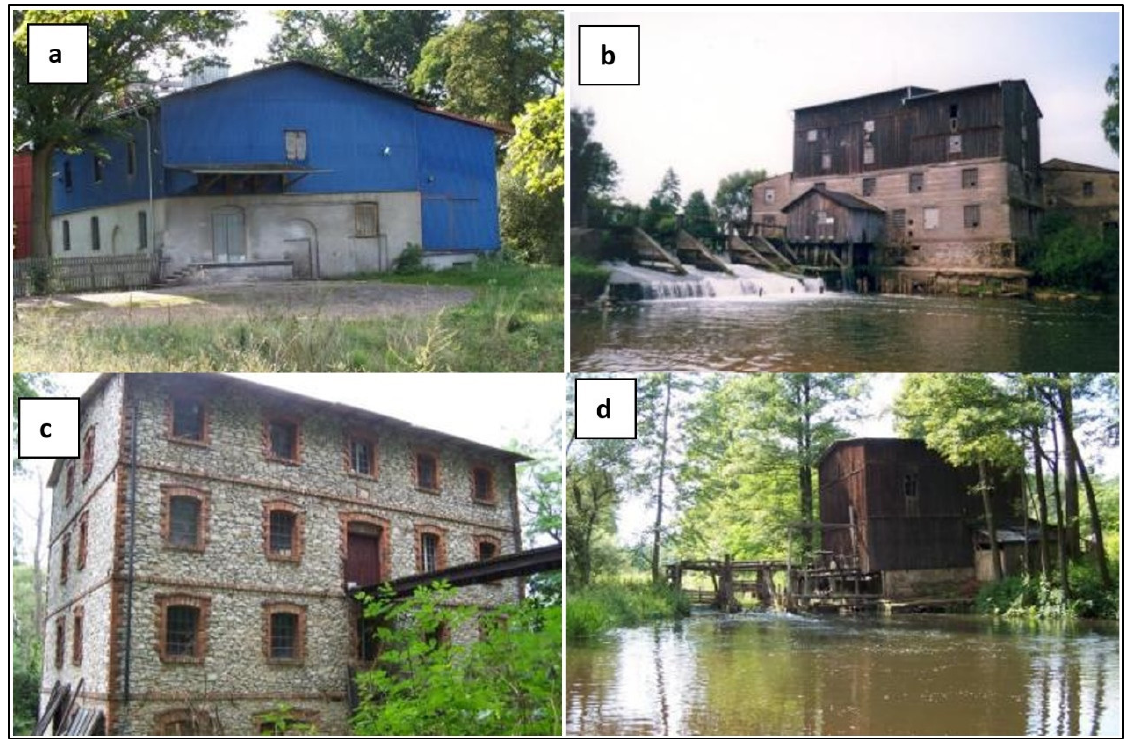
Figure 18. Contemporary Poland water mills: ( a ) historic mill in Kuźnica Stara on the River Pankówka, constructed in the early 20th century; ( b ) Marcelin mill in Krzepice, constructed in 1876; ( c ) mill in Troniny on the River Liswarta, constructed in 1901; and ( d ) Krym mill in the lower reach of the River Liswarta, constructed in early 20th century (adapted from [46]).